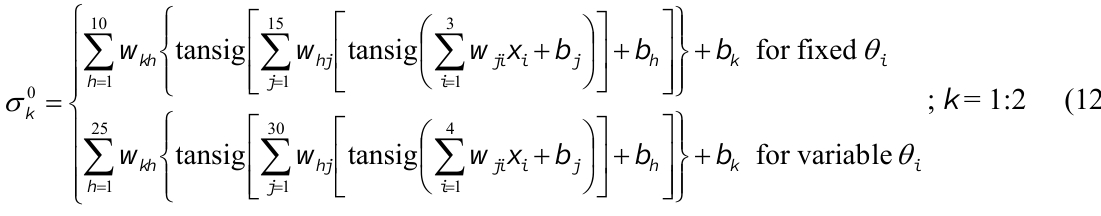
Figure 1. The Neural Network architectures. Upper panel: NN topology for the nominal incidence angle ( N